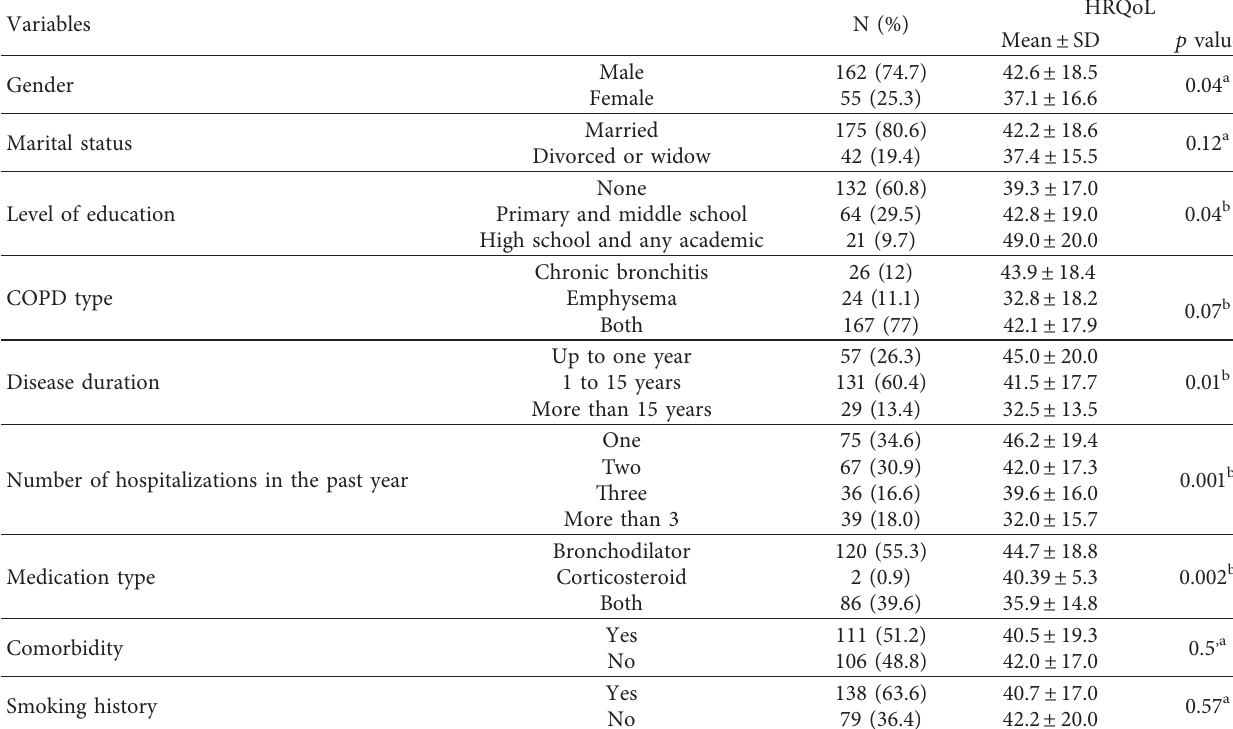
Table 1: Relationship between demographic characteristics and HRQoL in elderly patients with COPD.